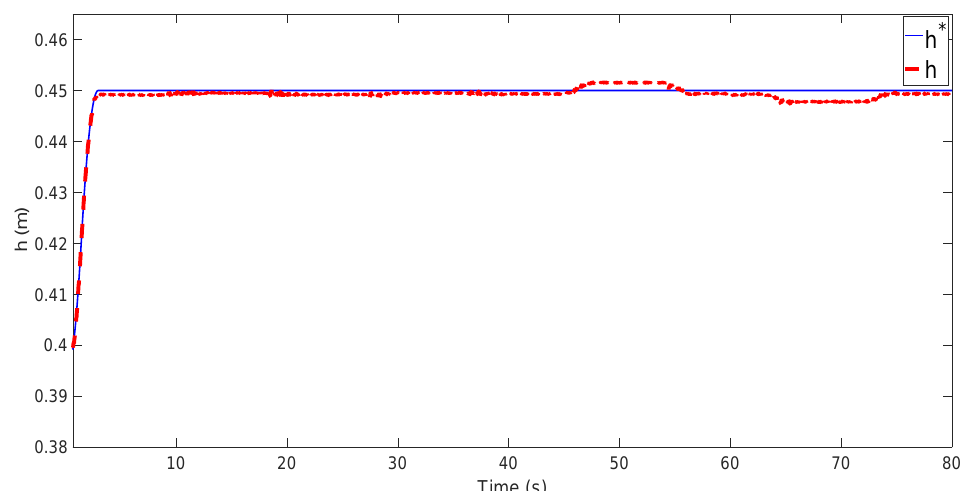
Figure 20. Height of the center of mass of frame